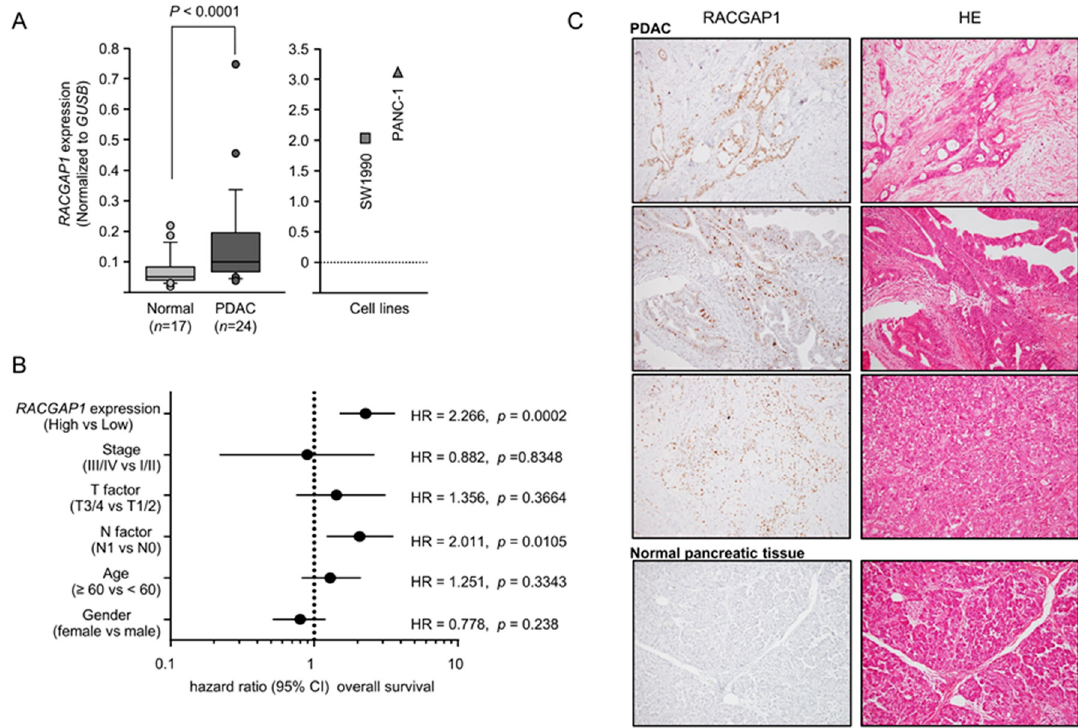
Figure 3. Aberrant expression of RACGAP1 in PDAC specimens and its clinical significance. ( A ) Expression levels of RACGAP1 in PDAC clinical specimens and two cell lines, SW1990 and PANC-1. GUSB expression was evaluated as the internal control. ( B ) Expression level of RACGAP1 in patients with PDAC according to data from TCGA database (https://cancergenome.nih.gov/). Forest plot of univariate Cox proportional hazards regression analyses of 5-year overall survival rates according to RACGAP1 expression and clinicopathological factors. ( C ) Immunohistochemical analysis of RACGAP1 in PDAC clinical samples. RACGAP1 was strongly expressed in cancer lesions. In normal pancreatic tissue, expression of RACGAP1 was not recognized. Original magnification: 200×.